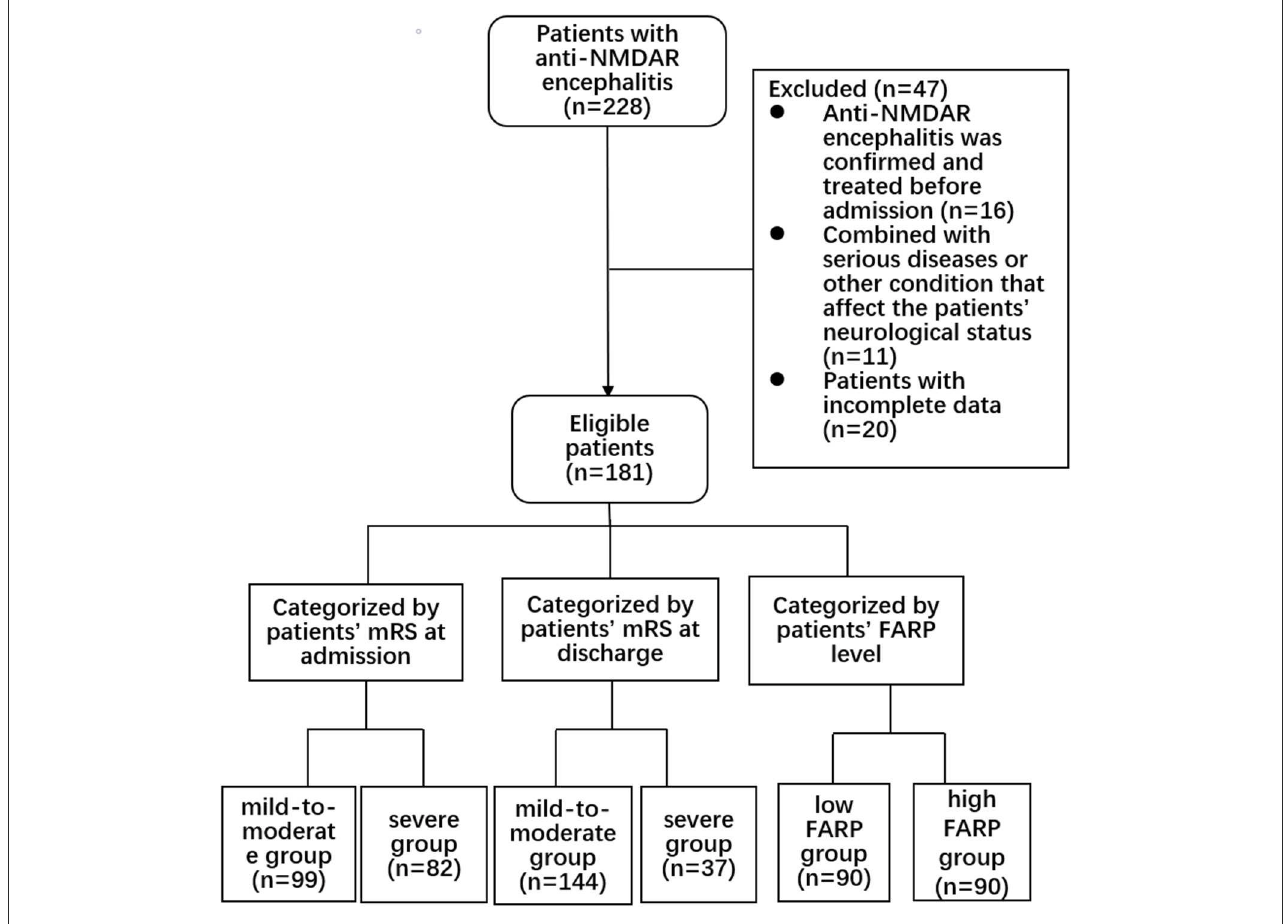
FIGURE1 Flow chart showing the patient screening